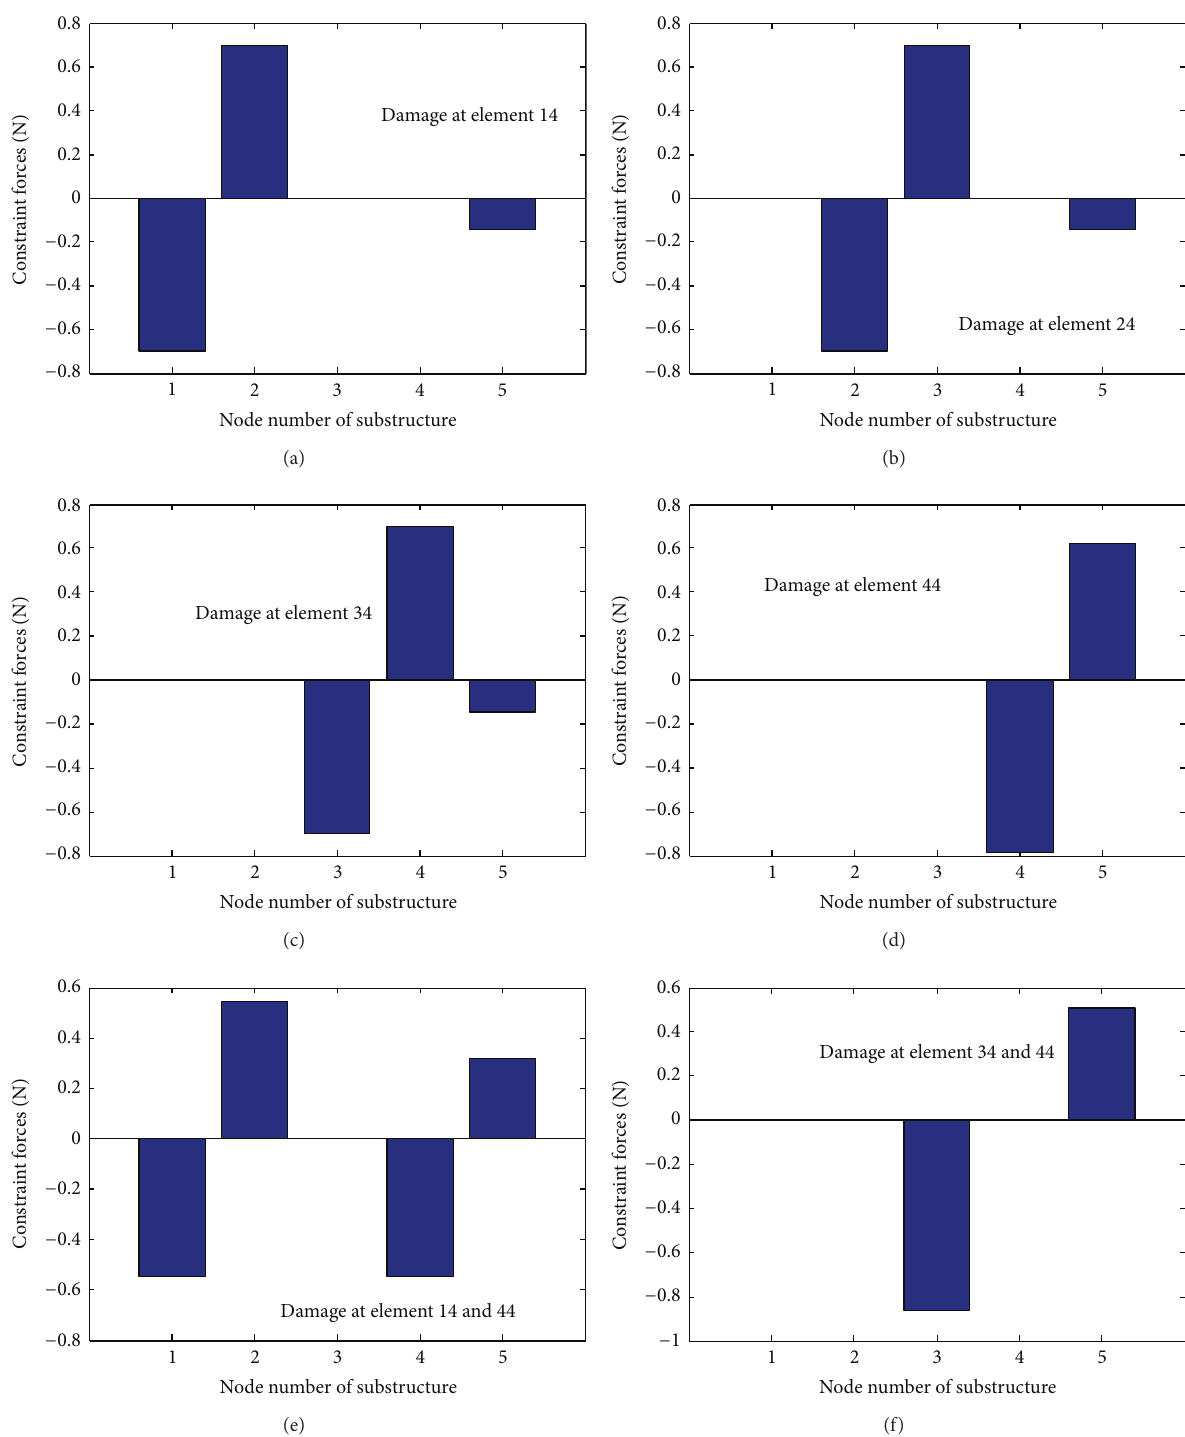
Figure 5: Constraint forces (noise-free): (a) damage at element 14, (b) damage at element 24, (c) damage at element 34, (d) damage at element 44, (e) damage at elements 14 and 44, and (f) damage at elements 34 and